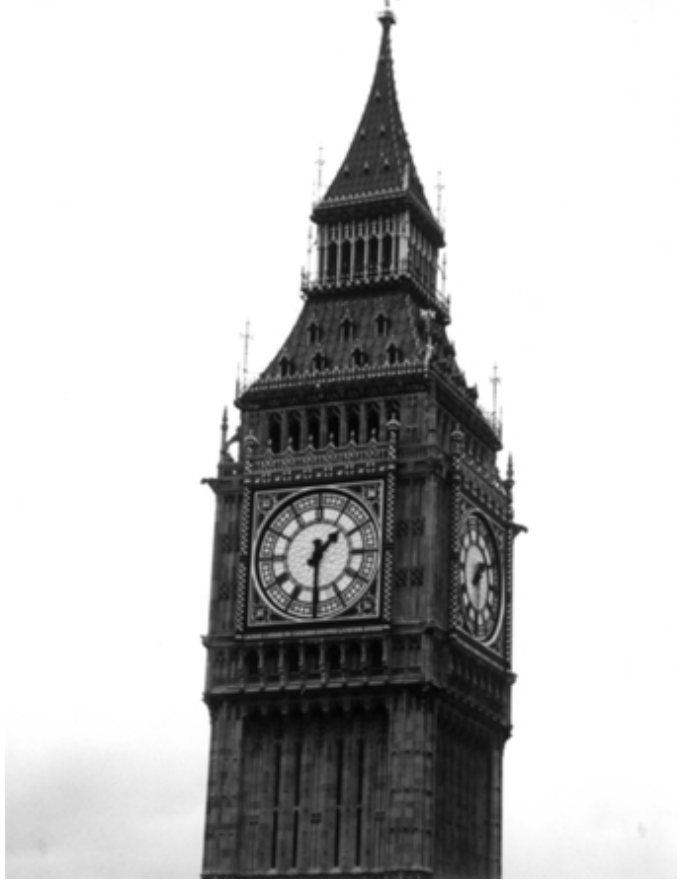
Fig. 3. Clock tower at the Palace of